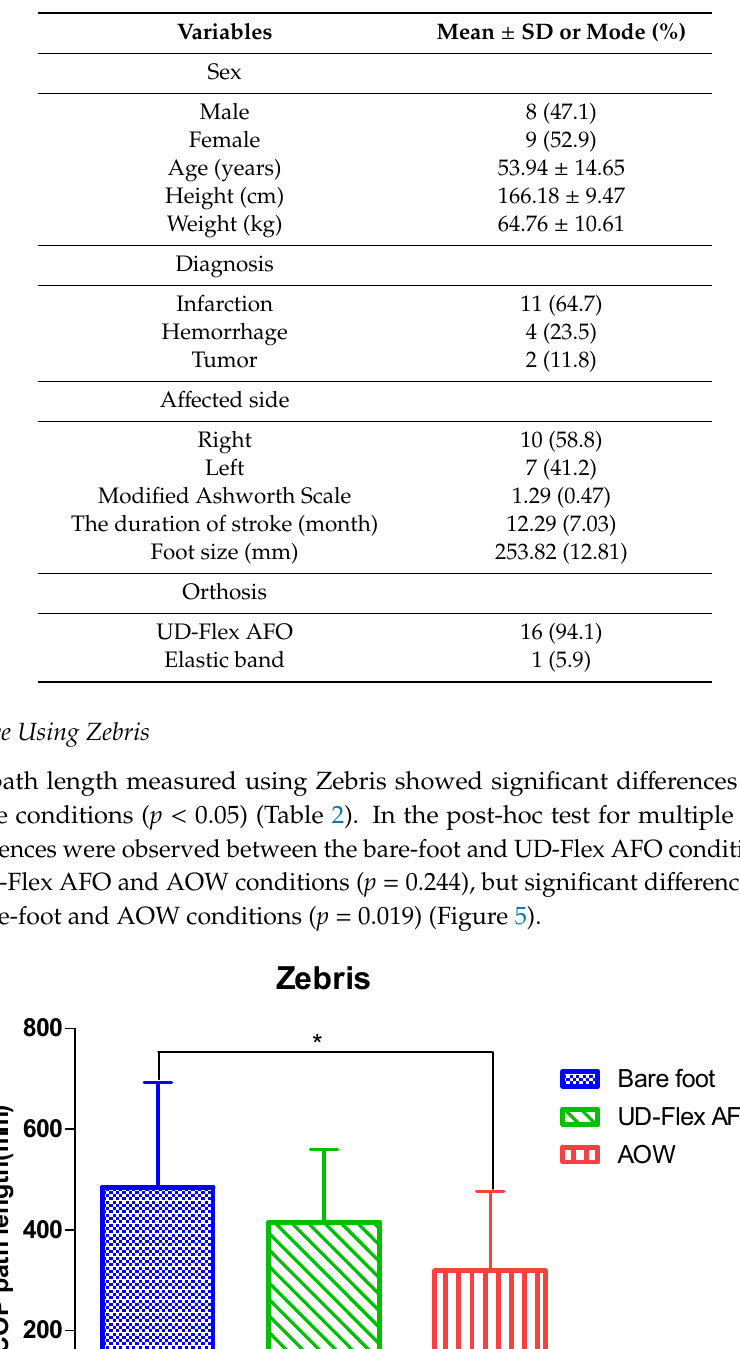
Table 1. General characteristics of patients ( n = 17).